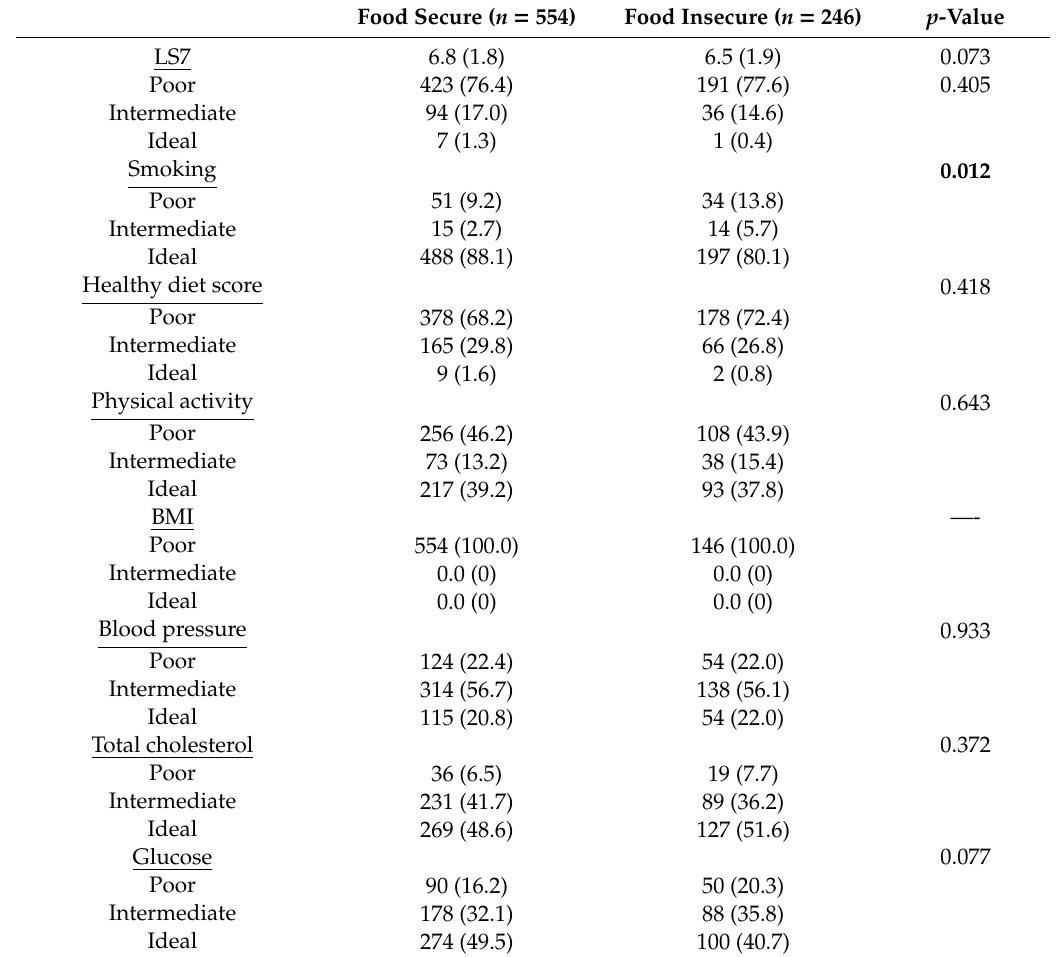
Table 3. LS7 Scores for PROPEL Patients by Food Security Status.